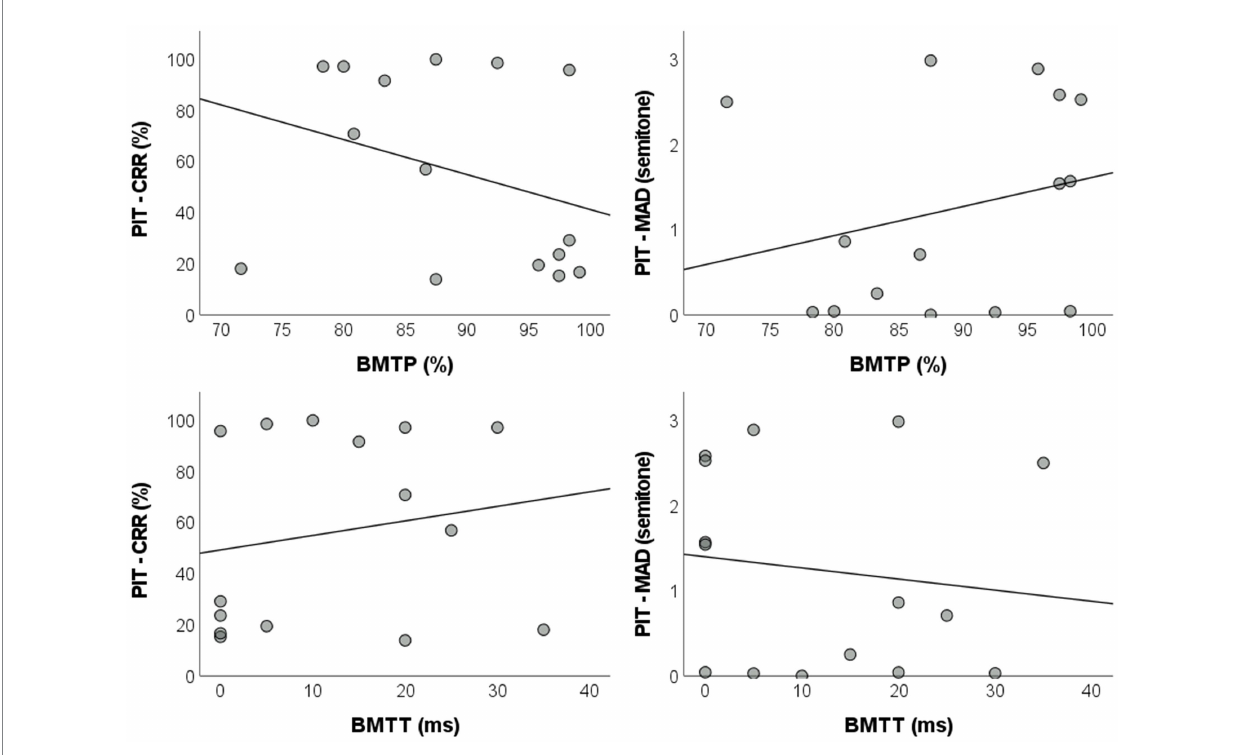
FIGURE 4 Dispersion plots with regression lines of the parameters for the pitch identification test and the BMT. BMT: backward masking test; BMTP: BMT percentage of correct responses; BMTT: BMT target sound detection threshold; PIT – CRR: pitch identification test – correct response rate; MAD: mean absolute